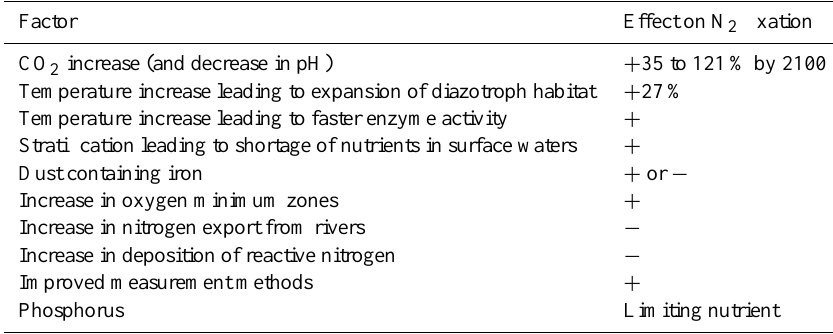
Table 2. Summary of future impacts of factors affecting marine nitrogen fixation. Factor Effect on N 2 fixation CO 2 increase (and decrease in pH) + 35 to 121% by 2100 Temperature increase leading to expansion of diazotroph habitat + 27% Temperature increase leading to faster enzyme activity + Stratification leading to shortage of nutrients in surface waters + Dust containing iron + or − Increase in oxygen minimum zones + Increase in nitrogen export from rivers − Increase in deposition of reactive nitrogen − Improved measurement methods + Phosphorus Limiting